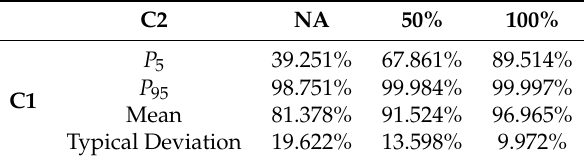
Table 7. Values of condition C1 depending on condition C2